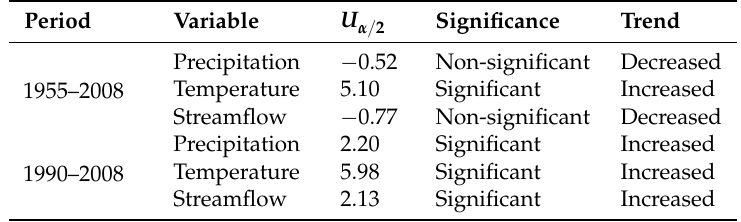
Table 3. Sensitivity analysis of the parameters and values selected for calibration.